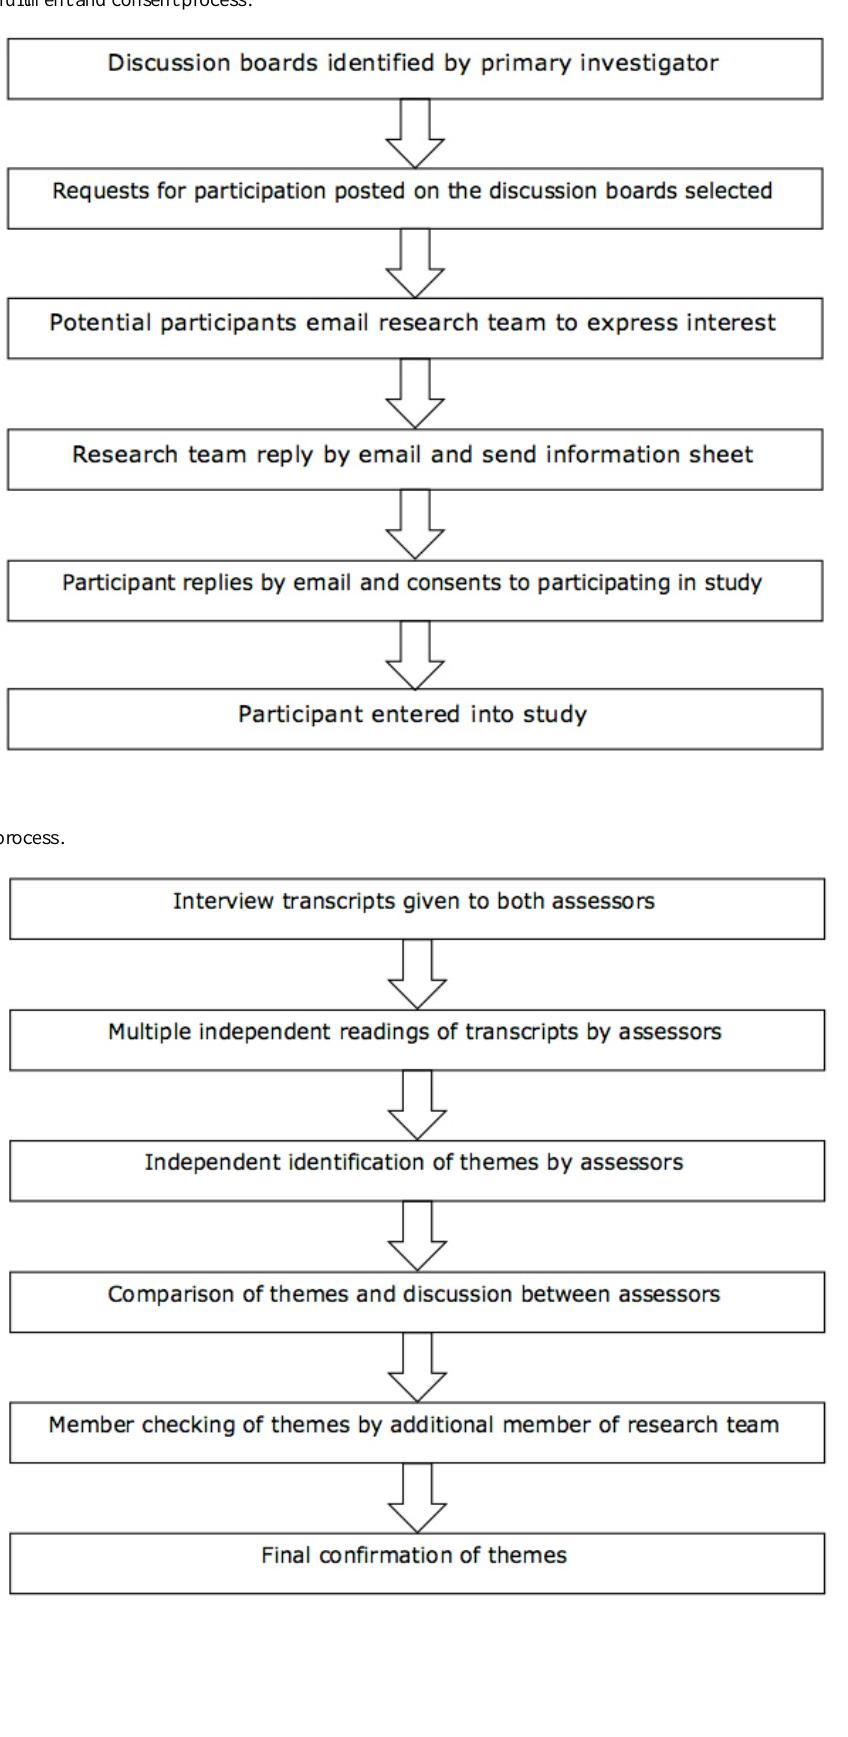
Figure 1. Participant recruitment and consent process.